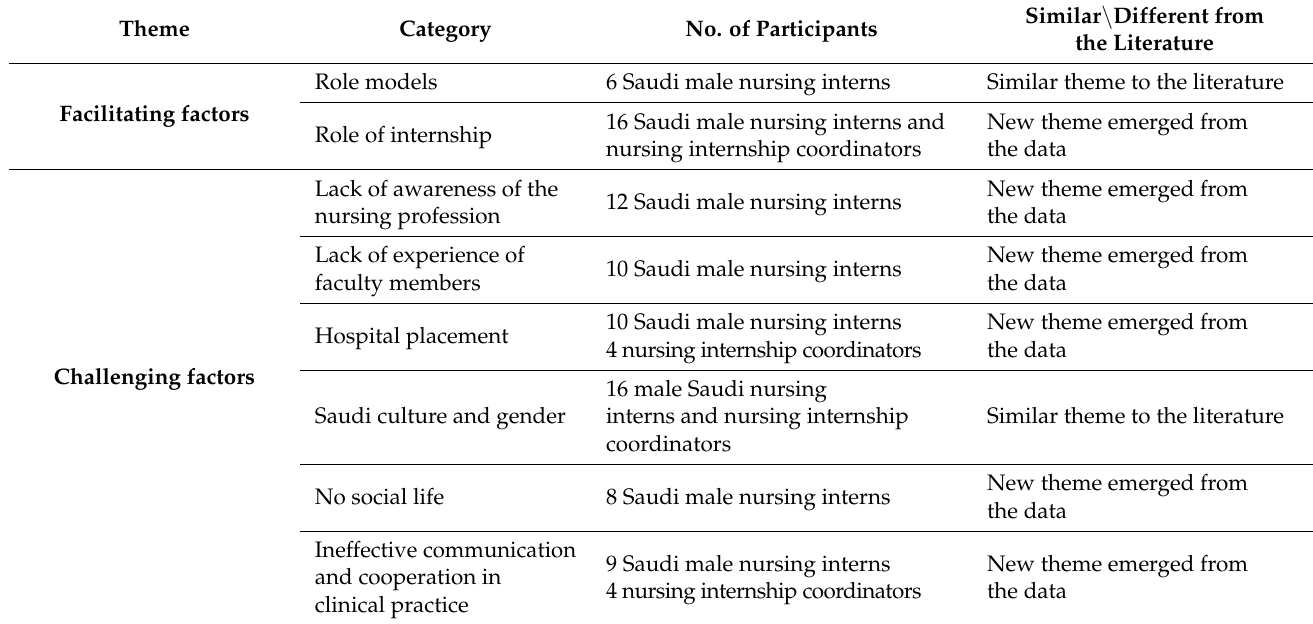
Figure 2. study themes and sub-themes. Figure 2. Study themes and sub-themes. Table 2. Themes, sub-themes, and number of